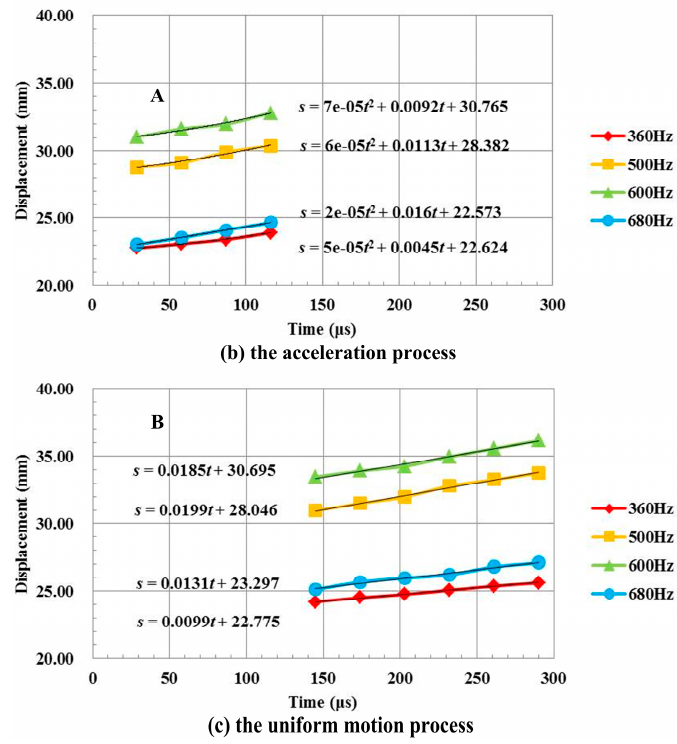
Figure 8. Curves of displacement–time for droplets at different frequencies. Table 4. Parameters of droplet movement.